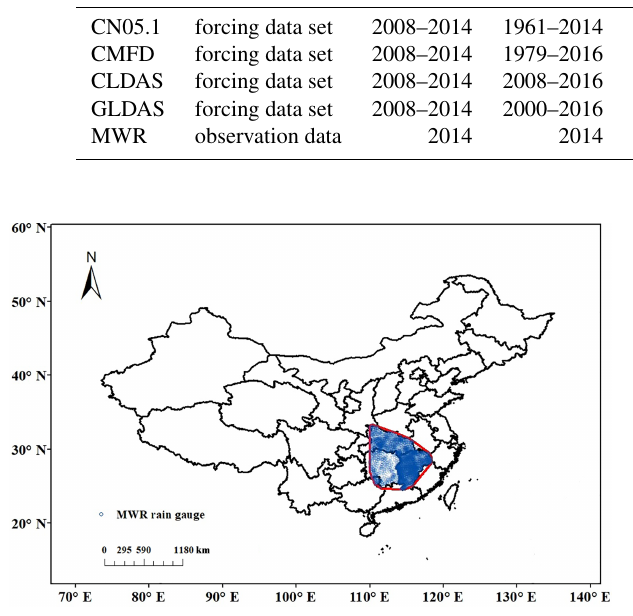
Figure 1. Locations of rain gauges operated by the Ministry of Wa- ter Resources of China, used as an independent source of precipita- tion data for validating the forcing data